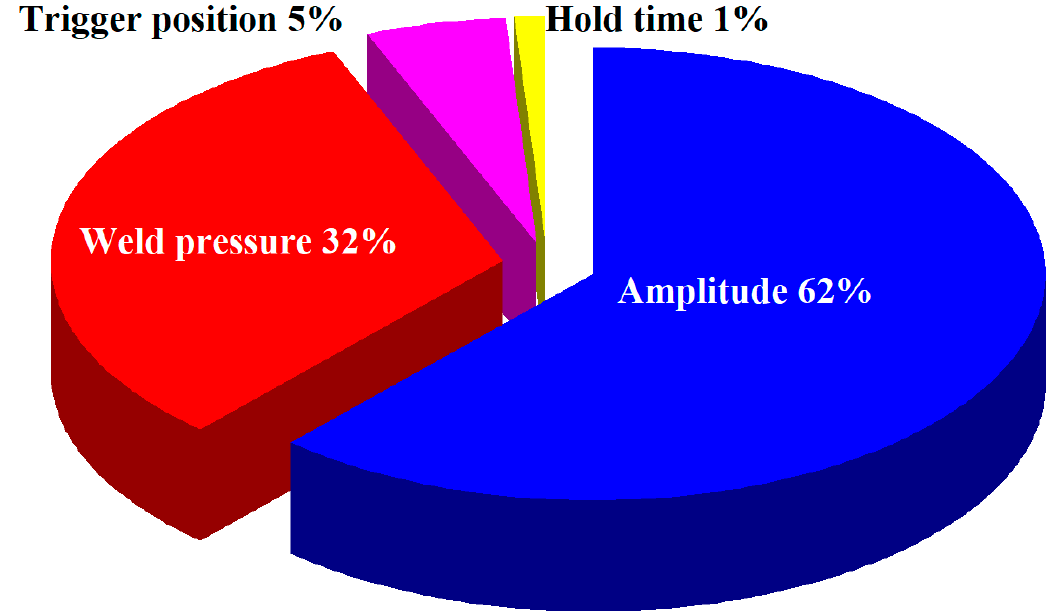
Figure 12. Schematic illustration of the percentage of contribution.